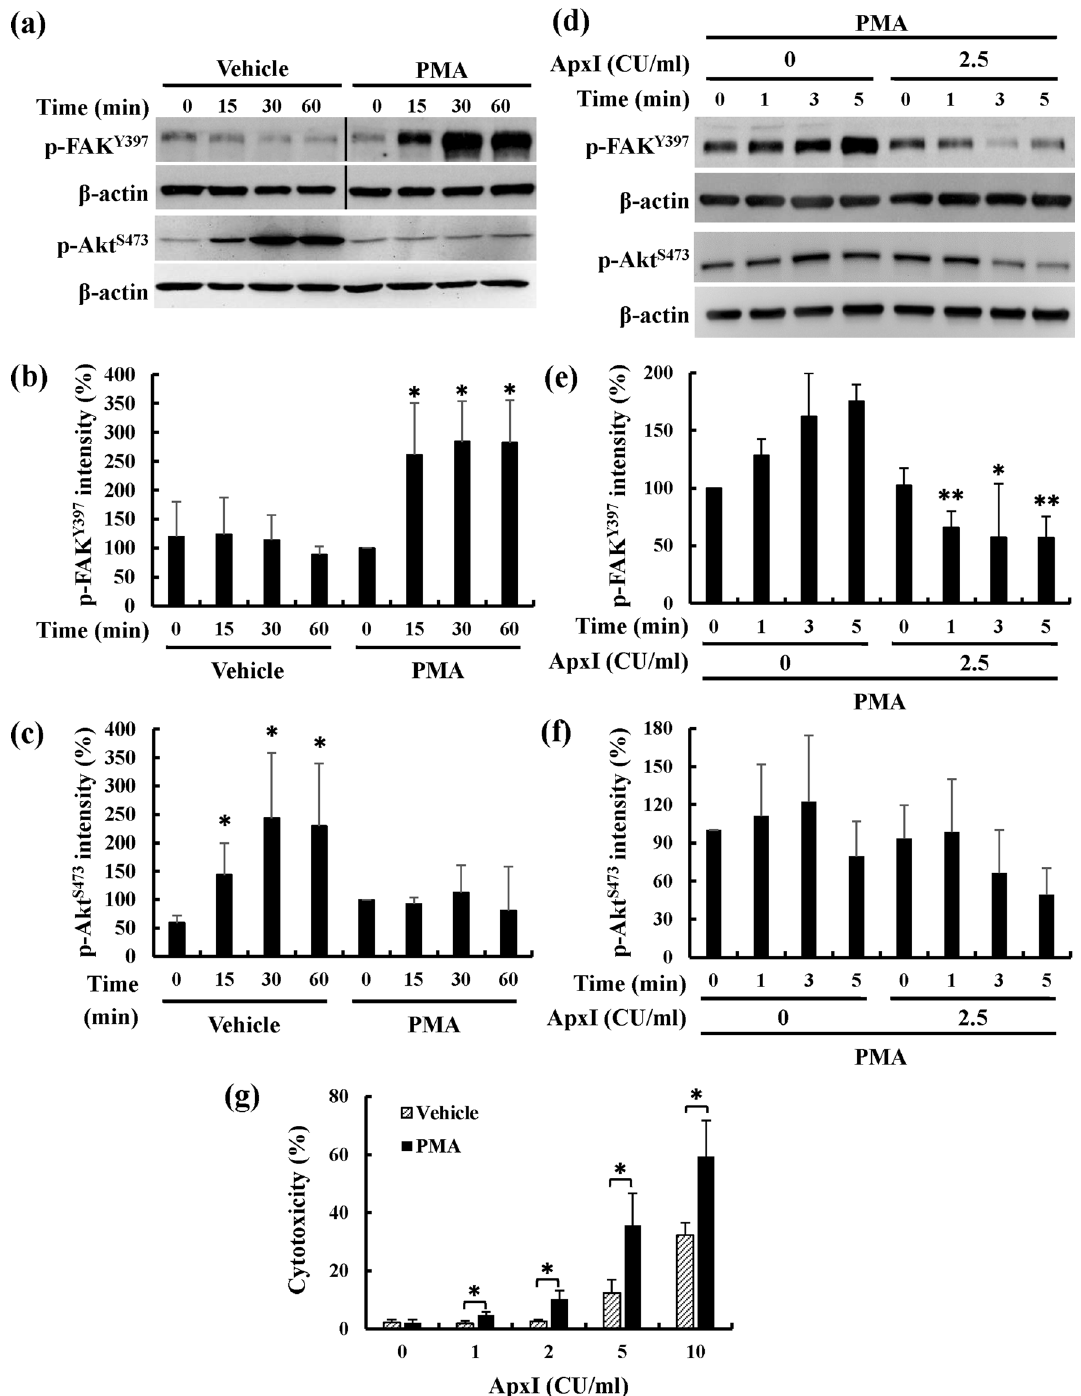
Figure 5. PMA fails to overcome ApxI-induced reduction in FAK and Akt activity and cytotoxicity. ( a – c ) Porcine AMs were treated with 200 nM PMA or 0.1% DMSO (Vehicle) for 0–60 min. Cell lysates were subjected to ( a ) Western blot analyses for p-FAK Y397 and p-Akt S473 . The grouping of blots was cropped from different portions of two gels and exposed separately. Black lines delineate the boundary between not contiguous lanes of the same gel. Uncropped blot images for ( a ) are presented in Supplementary Figure S4. The average intensities of ( b ) p-FAK Tyr397 and ( c ) p-Akt Ser473 are from three independent experiments and normalized to the intensity of β-actin. Asterisks indicate significant differences compared to the 0-min treatment group. * p < 0.05. ( d–f ) Porcine AMs pretreated with 200 nM PMA for 15 min were stimulated with 0 or 2.5 CU/ml of ApxI for 0–5 min. Cell lysates were collected and subjected to ( d ) Western blot analyses for p-FAK Y397 , p-Akt S473 , and β-actin. The grouping of blots was cropped from different portions of two gels and exposed separately. Uncropped blot images for ( d ) are presented in Supplementary Figure S5. The average intensities of ( e ) p-FAK Tyr397 and ( f ) p-Akt Ser473 are from three independent experiments and normalized to the intensity of β-actin. Asterisks indicate significant differences compared to the non-ApxI treatment group at the identical time point. * p < 0.05; ** p < 0.01. ( g ) Porcine AMs were incubated with 200 nM PMA or 0.1% DMSO (Vehicle) for 15 min, then incubated with 0–10 CU/ml of ApxI for 90 min. The percent cytotoxicity was quantified using the LDH release assay. Data are from three independent experiments of triplicate determinants. * p <